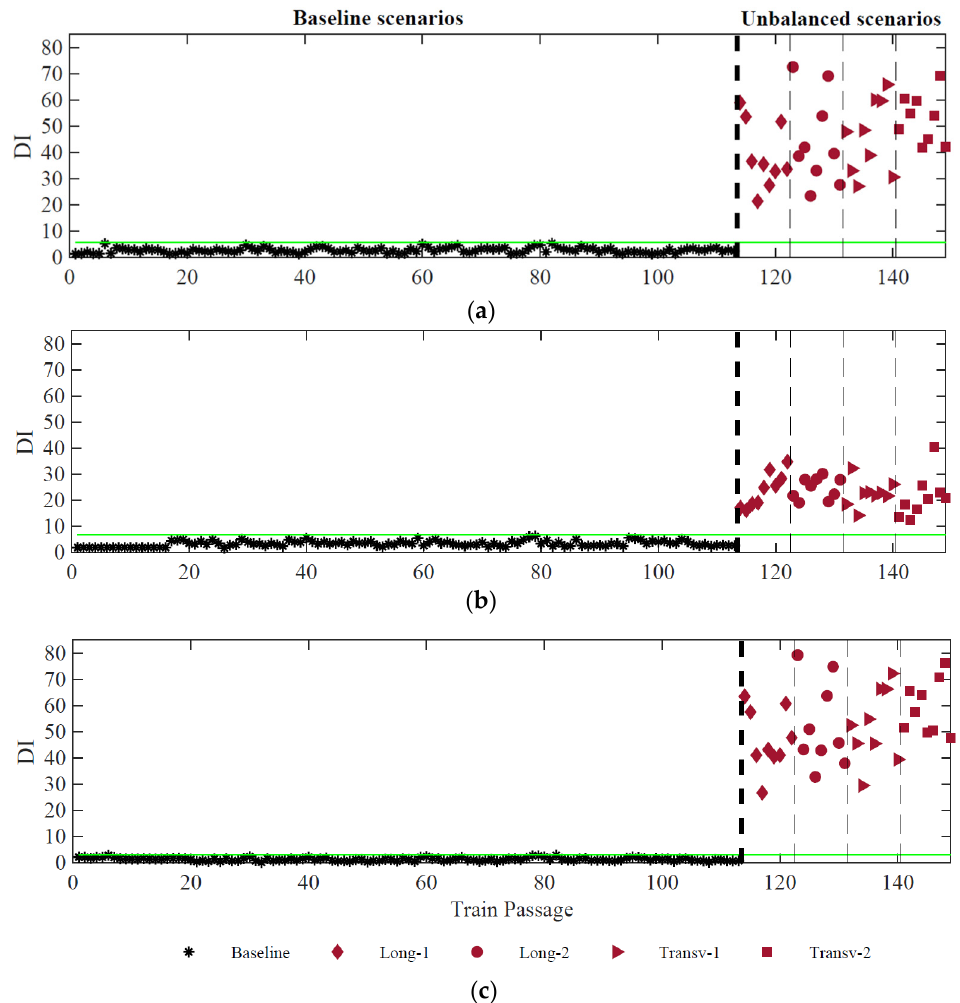
Figure 15. Automatic unbalanced loads detection based on ARX features considering the responses from: ( a ) 8 accelerometers; ( b ) 8 strain gauges; ( c ) 8 accelerometers + 8 strain gauges.